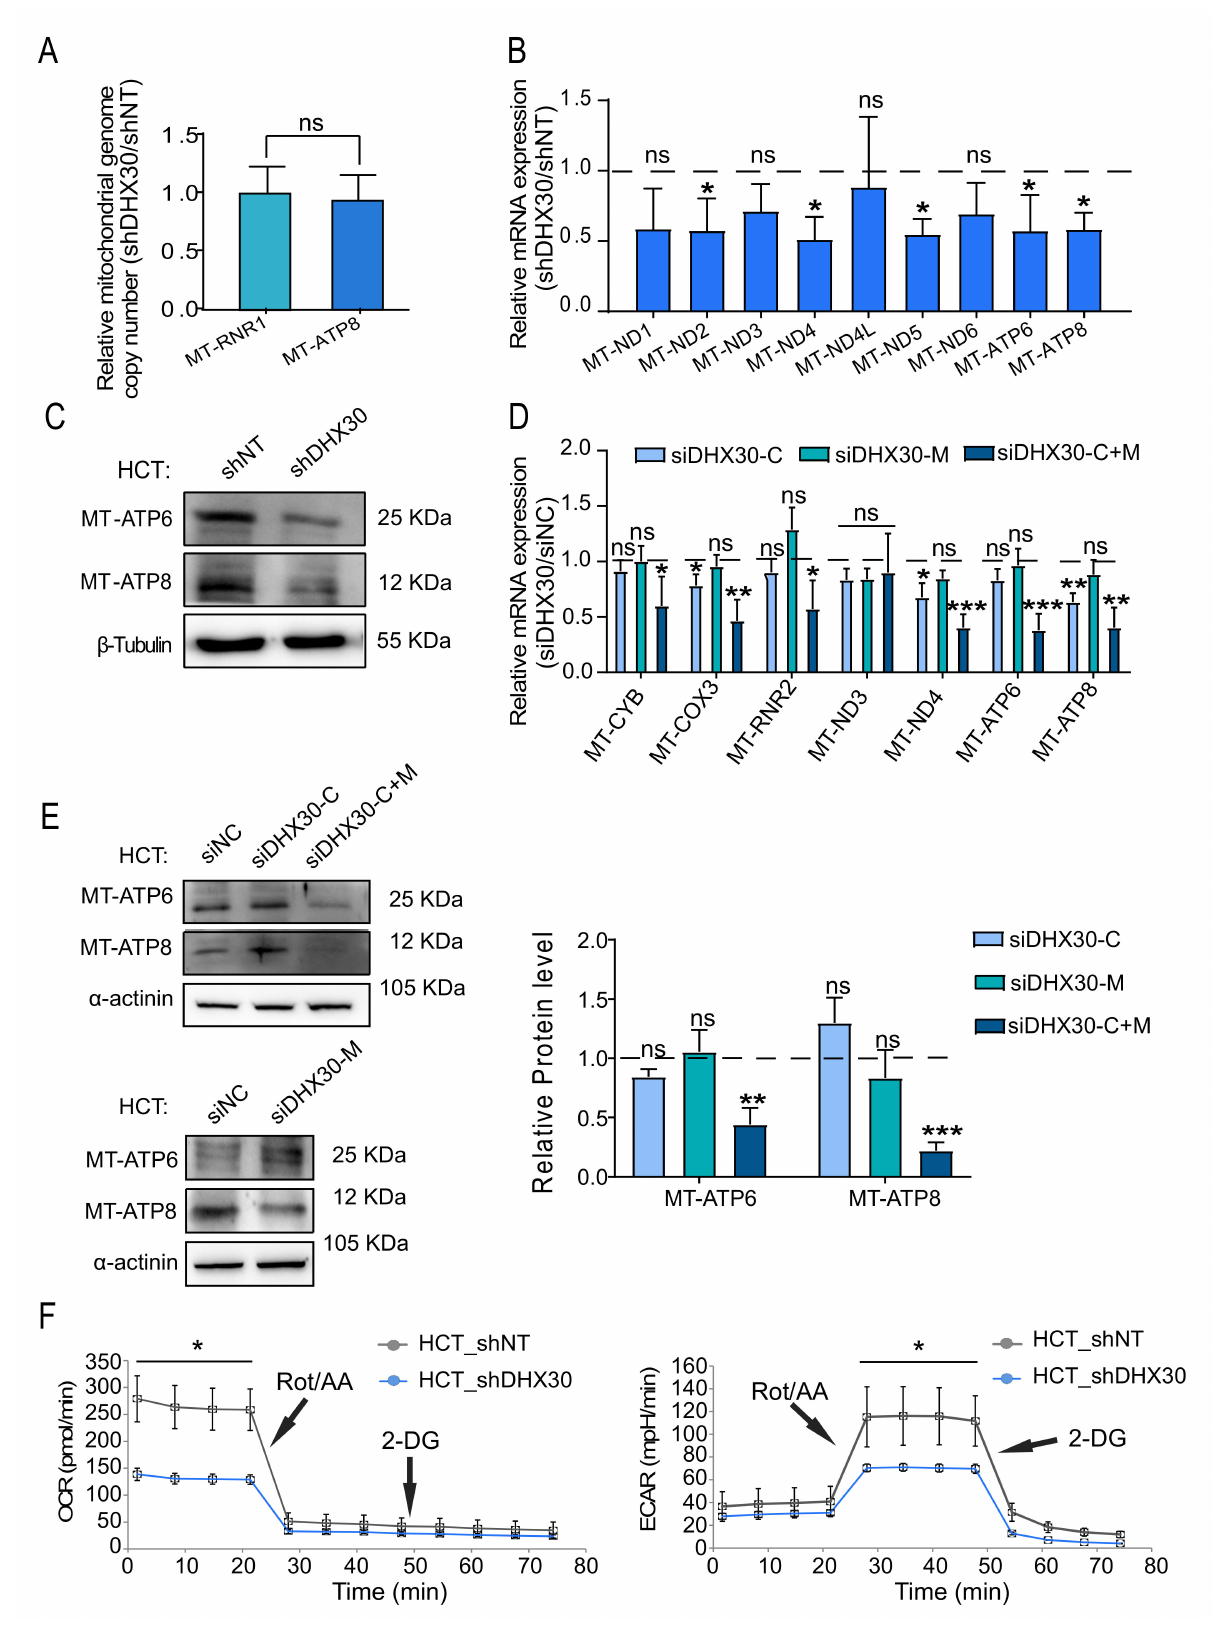
Figure 5. Depletion of DHX30 reduces the expression and function of mitochondrially encoded OXPHOS